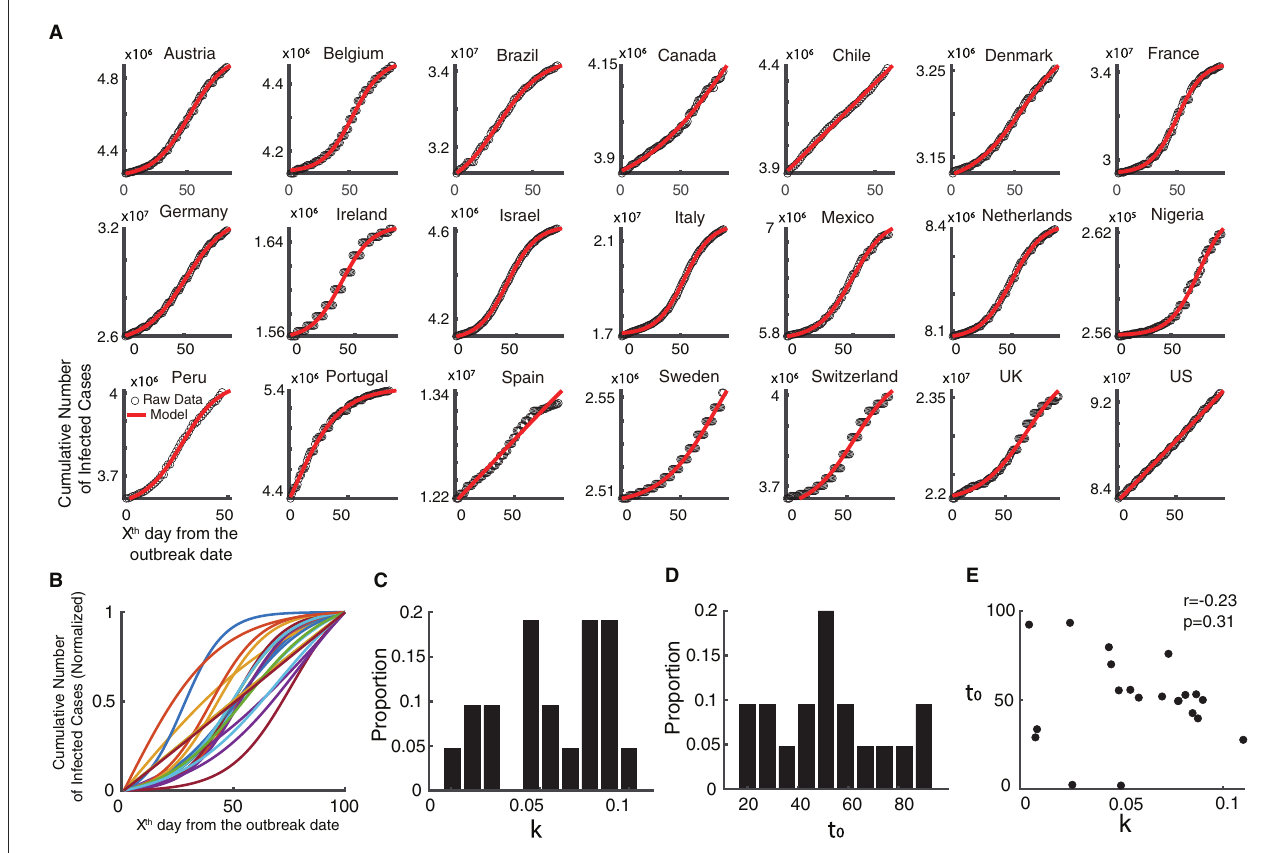
FIGURE2 Temporal dynamics of the ongoing COVID-19 epidemic. (A) Raw data of the cumulative infected cases of COVID-19 is shown in black dots and the fitted curve of the model is shown in red, in the same time interval as the monkeypox epidemic. (B) Normalized fitted curves of model for 21 countries. (C) Distribution of growth rate (k). (D) Distribution of semi-saturation period (t 0 ). (E) Relationship between growth rate (k) and semi-saturation period (t 0